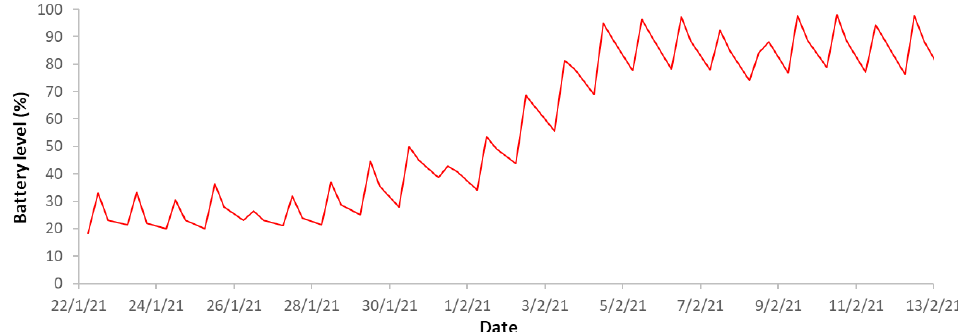
Figure 4. Energy balance of the Coordinator (always on; receiving and sending to cloud 14 full data packets per hour) starting at 20% battery level charging solely on solar harvesting panels during winter.